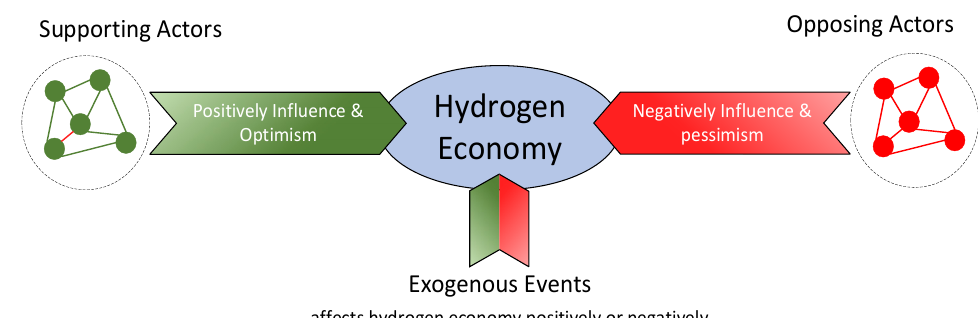
Figure 9. Conceptual framework of the influences towards hydrogen